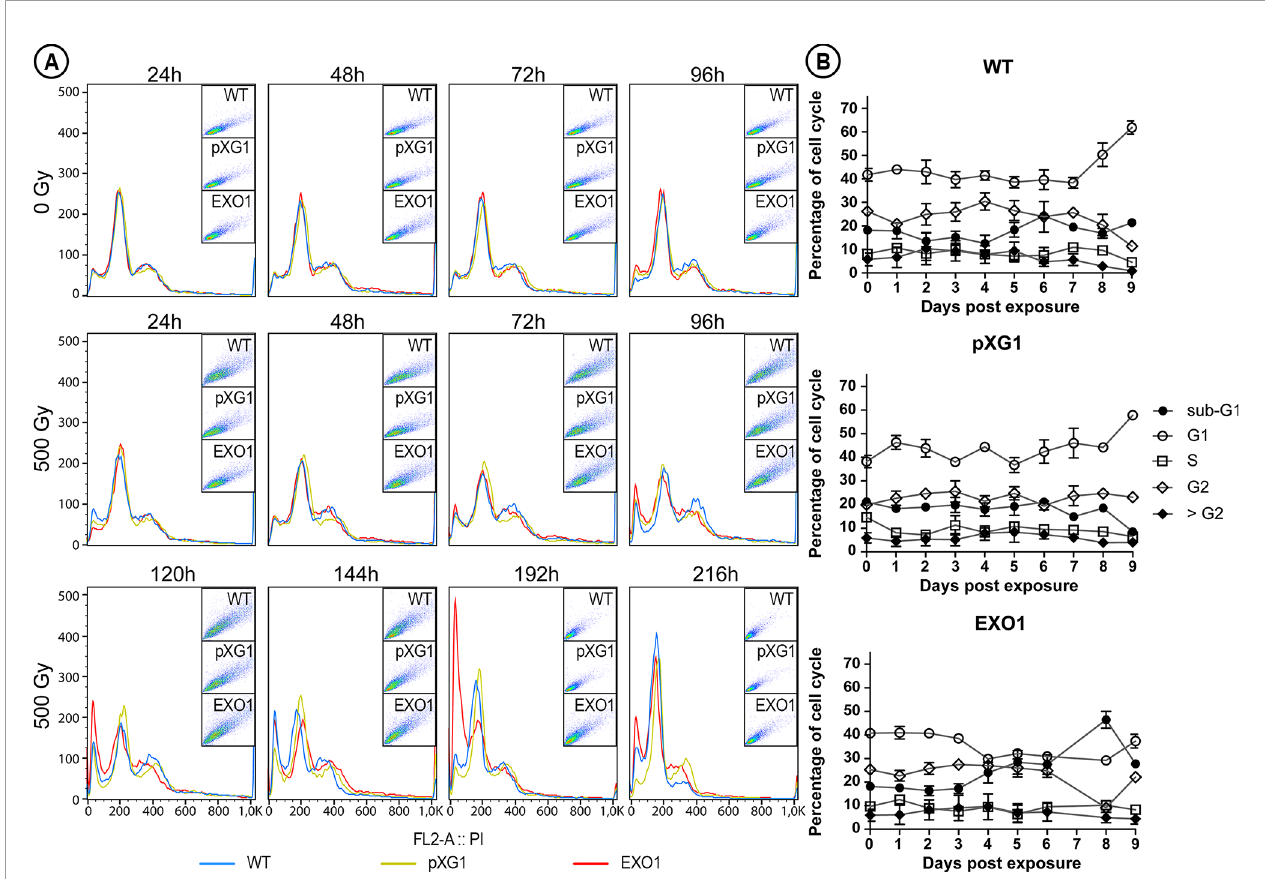
FIGURE 3 | Cell cycle of the different L. major lineages exposed to ionizing radiation. (A) The histograms compare the cell populations of L. major wild type (WT, blue curves); episome vector control ( “ pXG1 ” , golden curves); e LmjEXO1 overexpressor lineage ( “ EXO1 ” , red curves) not exposed ( “ 0 Gy ” ) and exposed to 500Gy ( “ 500Gy ” ) of gamma radiation during the analyzed period. The population was distributed according to the fl uorescence intensity of propidium iodide (PI) of each cell. The inset graphs at the right upper corner of each histogram represent the population of parasites from which the data was extracted for the generation of the histograms. The data are representative of two independent experiments. (B) The percentage of parasites in each stage of the cell cycle, extracted from the histograms, was plotted as curves to demonstrate the evolution of each L. major after the irradiation. Sub-G1: full circles; G1: empty circles; S: empty squares; G2: empty diamonds; > G2: full diamonds. The data was presented as mean ± standard error of the percentages obtained from the two independent